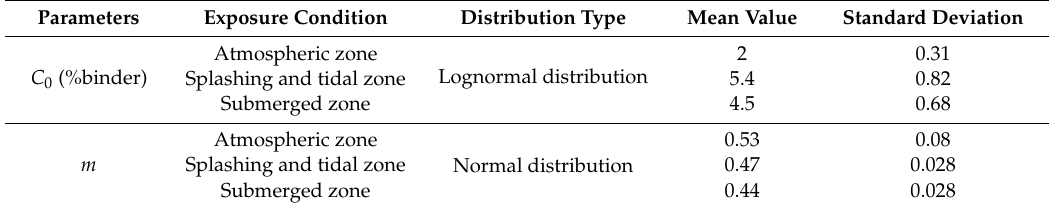
Table 1. The statistical distribution of surface chloride concentration and age